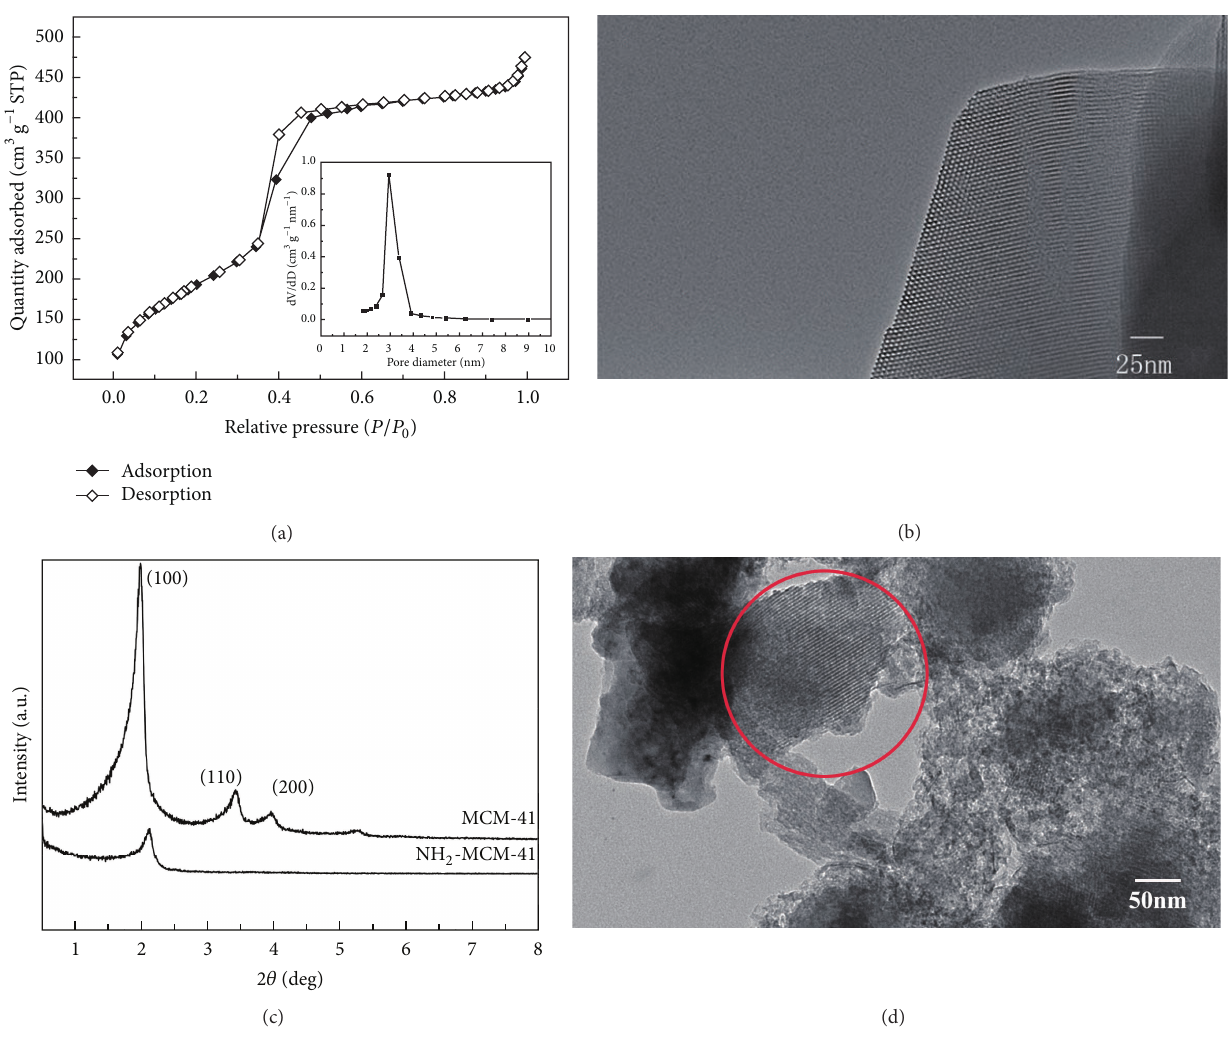
Figure1:(a)NitrogenadsorptionisothermofMCM-41.(b)TEMimageoftheMCM-41.(c)XRDpatternsoftheMCM-41andNH 2 -MCM-41. (d) SEM image of NH 2 -MCM-4.